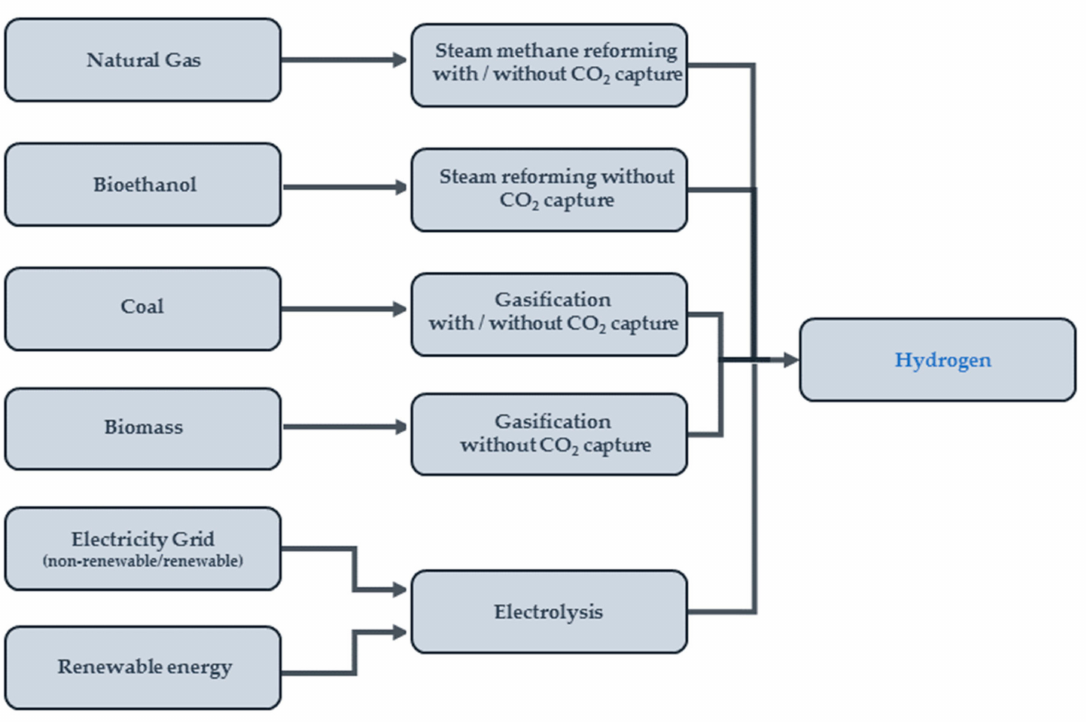
Figure 9. Hydrogen production